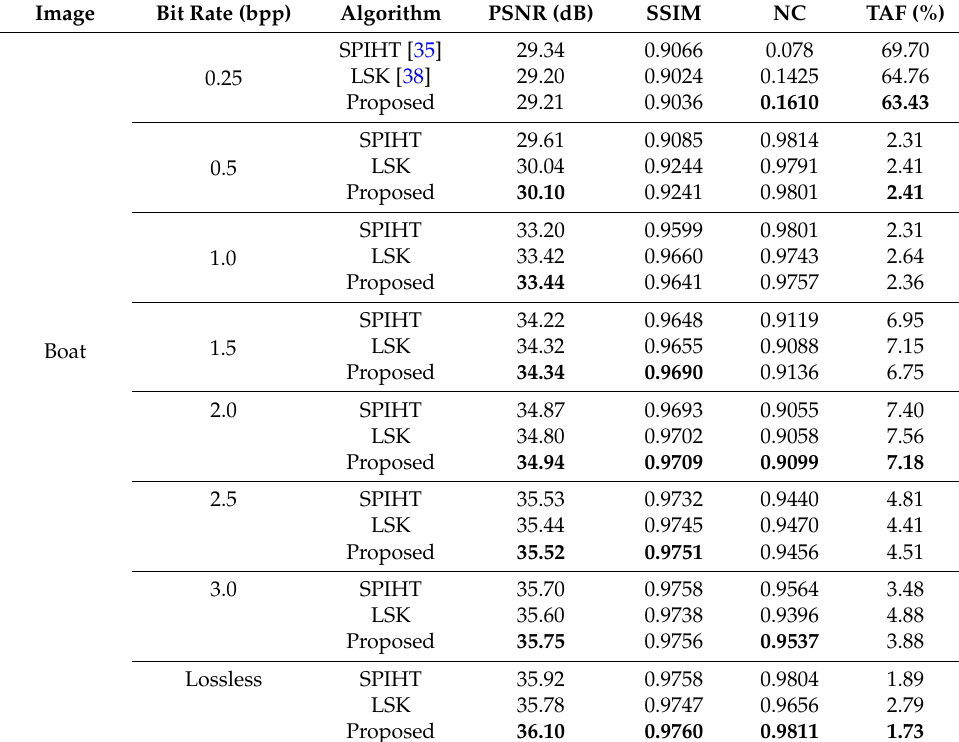
Table 3. PSNR, SSIM, TAF and NC performance on the Boat